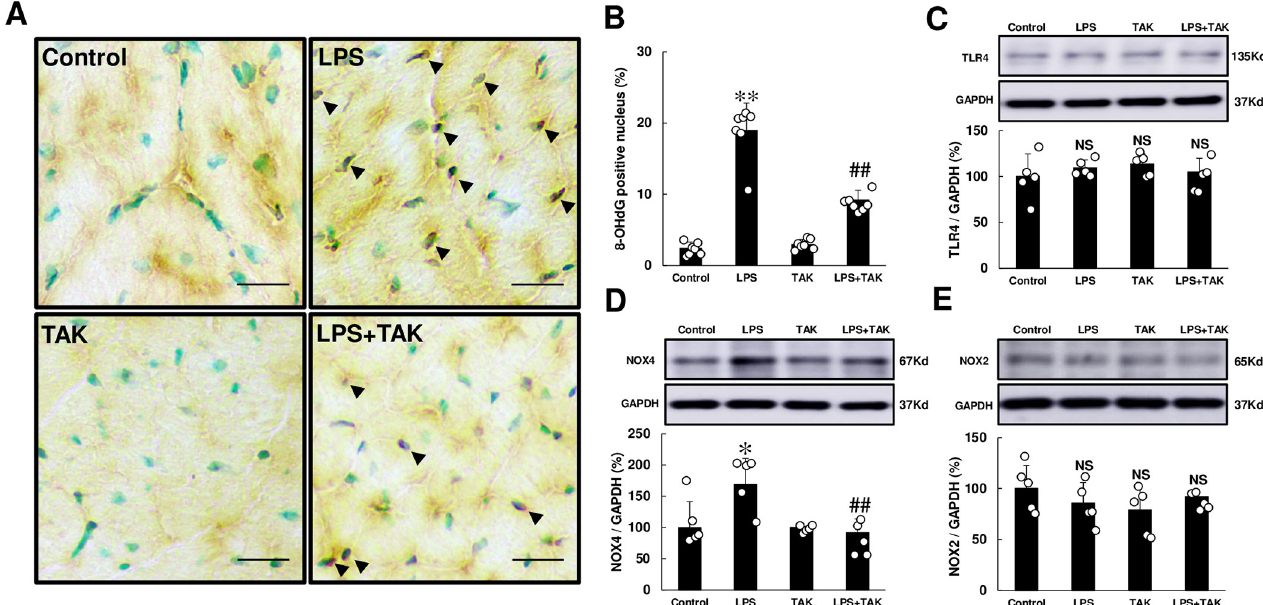
Fig 4. Effects of chronic PG-LPS infusion on oxidative stress. (A) Representative images of 8-OHdG-immunostained sections of cardiac muscle in the Control ( upper left ), PG-LPS (LPS) ( upper right ), TAK-242 (TAK) ( lower left ) and PG-LPS + TAK-242 (LPS + TAK) ( lower right ) groups. Scale bars: 2 μ m. Black arrows: TUNEL-positive myocytes. (B) The number of 8-OHdG-positive myocytes was significantly increased in the PG-LPS group, and this increase was significantly attenuated by TAK-242. �� P < 0.01 vs. Control or ## P < 0.01 vs. PG-LPS group by one-way ANOVA followed by the Tukey-Kramer post hoc test. (C) TLR4 expression was similar among the four groups. NS, not significantly different from the Control ( P > 0.05) by one-way ANOVA followed by the Tukey-Kramer post hoc test. Full-size images of immunoblots are presented in S6 Fig of S1 Data . (D) NOX4 expression was significantly increased in the PG-LPS group, and this increase was significantly attenuated by TAK-242. � P < 0.05 vs. Control or ## P < 0.01 vs. PG-LPS group by one-way ANOVA followed by the Tukey-Kramer post hoc test. Full-size images of immunoblots are presented in S7 Fig of S1 Data . (E) NOX2 expression was similar among the four groups. NS, not significantly different from the Control ( P > 0.05) by one-way ANOVA followed by the Tukey-Kramer post hoc test. Full-size images of immunoblots are presented in S8 Fig of S1 Data . Data shows means ± SD and scattered dots show individual data.